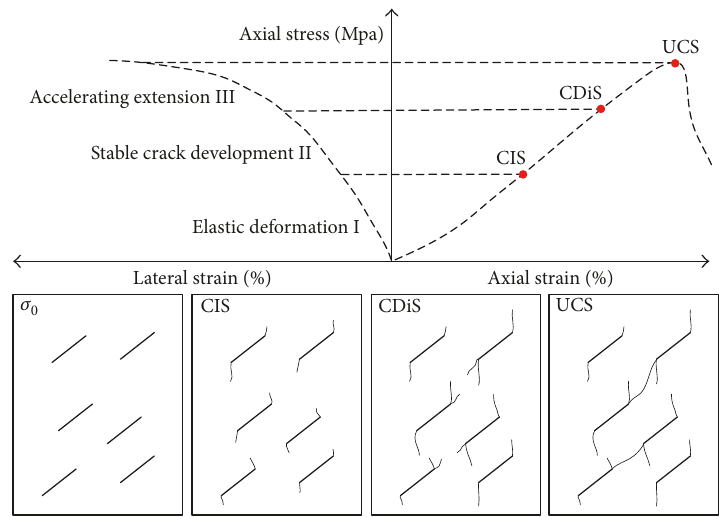
Figure 8: Stress-strain diagrams for different stages of crack development and sketches of crack propagation under different stress levels.